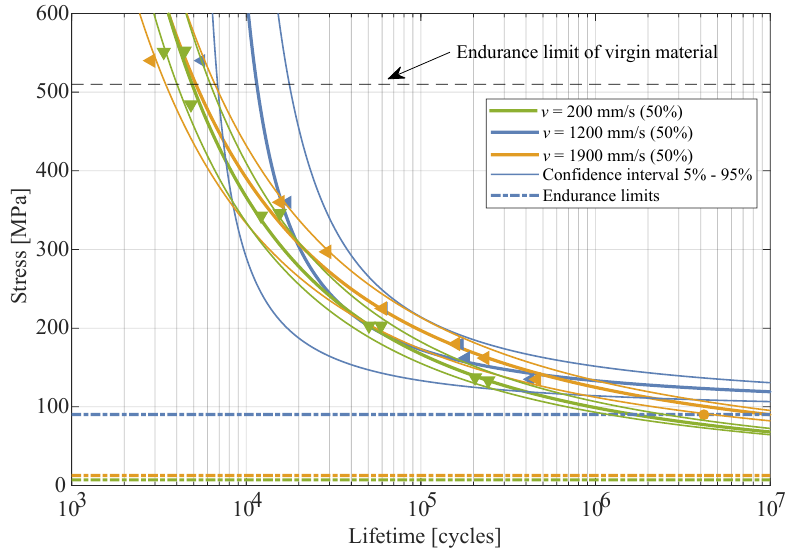
Figure 9. Comparison of S–N fields for different laser velocities: v = 200 mm/s (data from Edwards and Ramulu [6]), v = 1200 mm/s and v = 1900